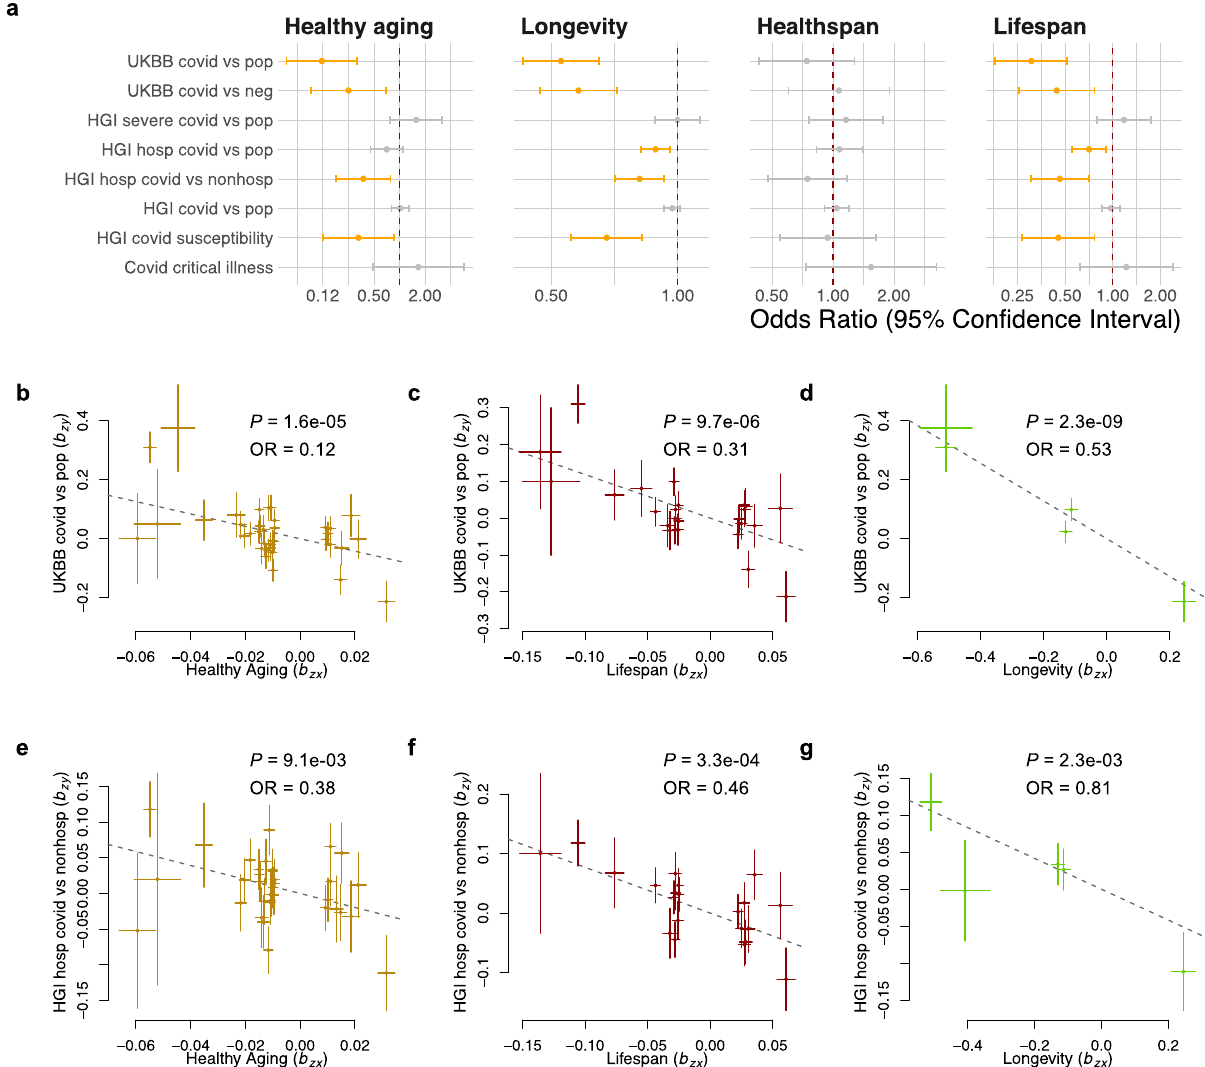
Fig. 1 Mendelian randomization analysis reveals an association of lifespan-related traits with the risk of COVID-19. a Forest plot shows Mendelian randomization estimates for the causal effect of lifespan-related traits on the risk of COVID-19. Error bars show 95% con fi dential interval. Signi fi cant effects with FDR < 0.05 are in orange. Nominally signi fi cant effects ( P < 0.05) are in black. Plots of effect sizes of all genetic instruments from GWAS for healthy aging ( b ), lifespan ( c ), and longevity ( d ) ( x -axis) versus those for UKBB COVID-19 ( y -axis); and the same set of exposure traits ( e − g ) ( x -axis) versus HGI COVID-19 hospitalization ( y -axis). Error bars represent standard errors. UKBB UK Biobank, HGI Host Genetics Initiative, pop population control, OR Odds